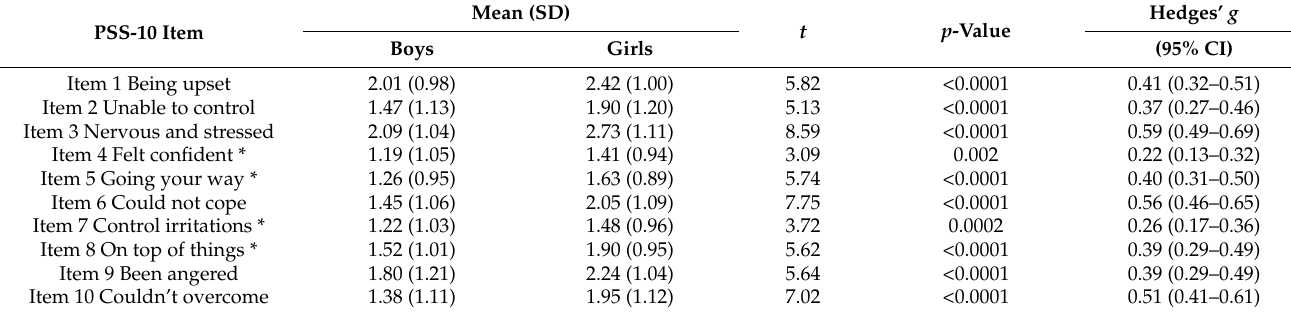
Table 2. Gender differences in mean scores across all ten items of the Perceived Stress Scale, PSS-10.